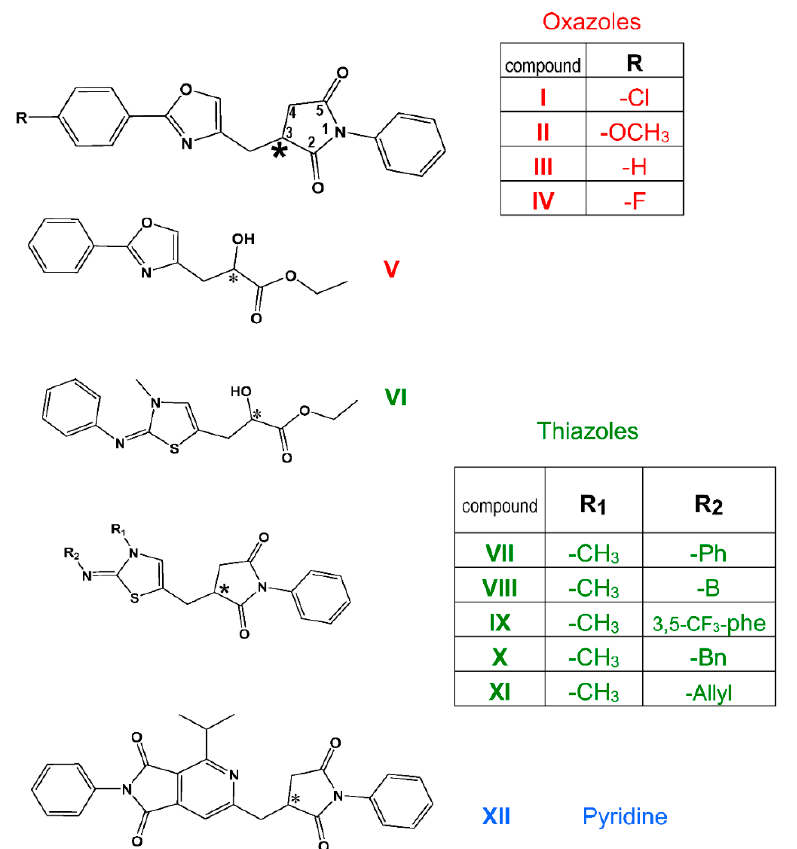
Figure 1. Newly synthesized azole compounds. I-IV and VII-XII are N -phenylmaleimide adducts; V and VI are ethylglyoxylate adducts. Oxazoles I-V in red; thiazoles VI-XI in green. Code: * stereo- genic center; -Ph: phenyl group; -Bn: -CH 2 -Ph or benzyl group; -allyl: -CH 2 -CH=CH 2 group.